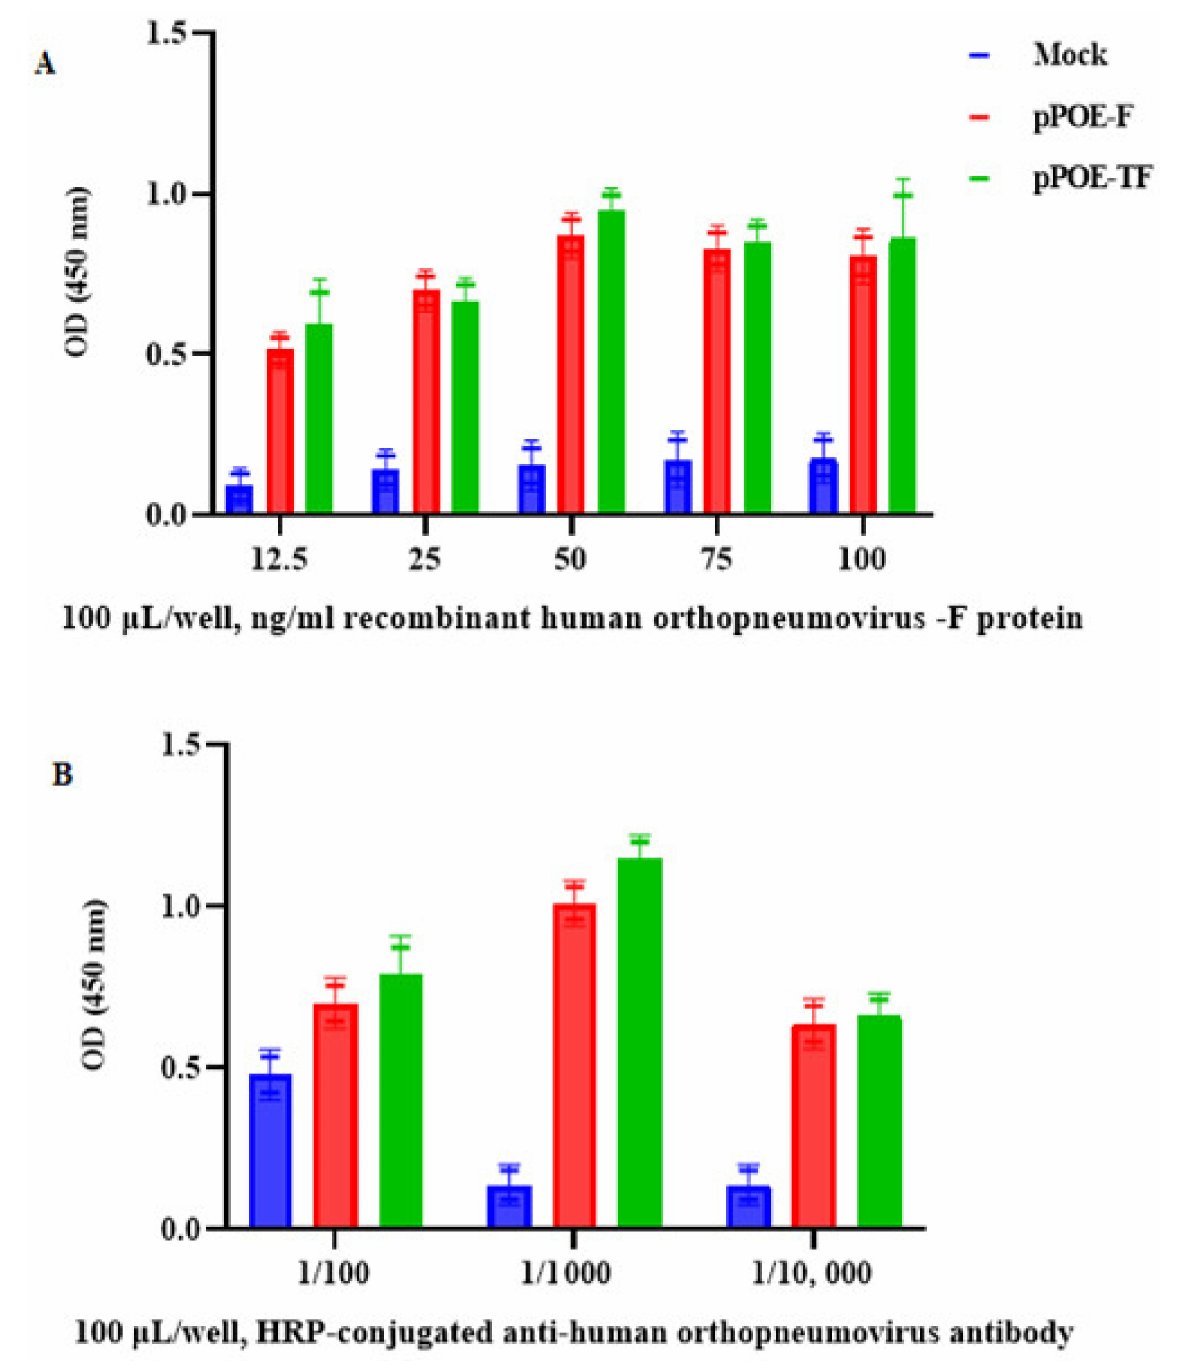
Figure 4. ( A ) Graph showing optimum concentrations of recombinant human orthopneumovirus F protein. Different concentrations of recombinant human orthopneumovirus F protein were added and detected by various dilutions of HRP-conjugated anti-RSV antibody. ( B ) Graph showing the various dilutions of HRP-conjugated anti-human orthopneumovirus antibody. OD values are the mean of two independent experiments and bars represent means ± SD measured in each MPA. Differences between rats immunized with pPOE-F and pPOE-TF were statistically